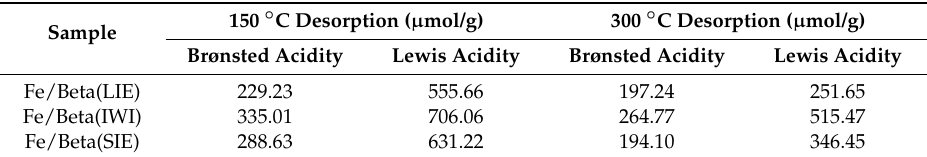
Figure 12. FT-IR spectra of pyridine adsorption at 300 °C on Fe/Beta catalysts. Table 2. Concentration of surface acid sites of Fe/Beta catalysts.